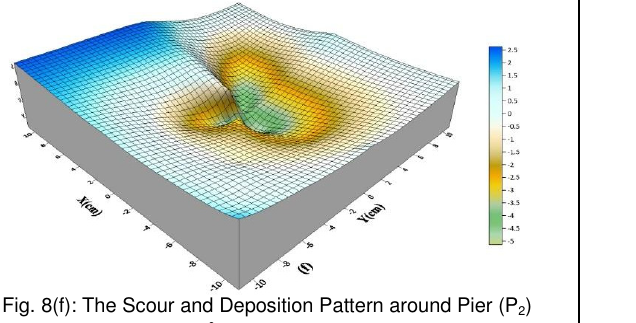
Fig. 8(f): The Scour and Deposition Pattern around Pier (P 2 ) at angle 7 0 and flowrate 18L/Sec. The green area denotes maximum scouring pattern